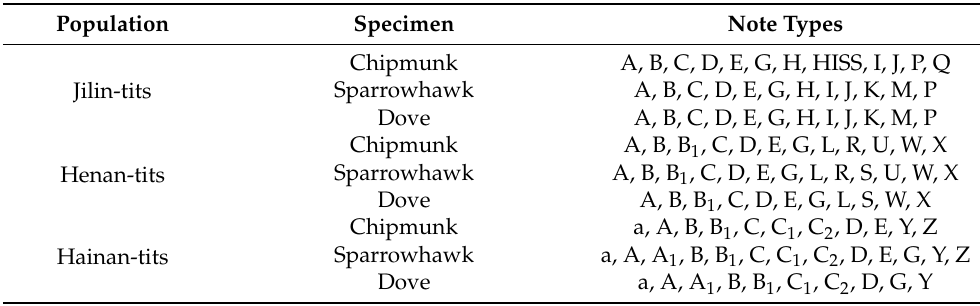
Table 1. Note types in alarm calls of three populations of Japanese tits in response to common chipmunks, sparrowhawks, and Oriental turtle